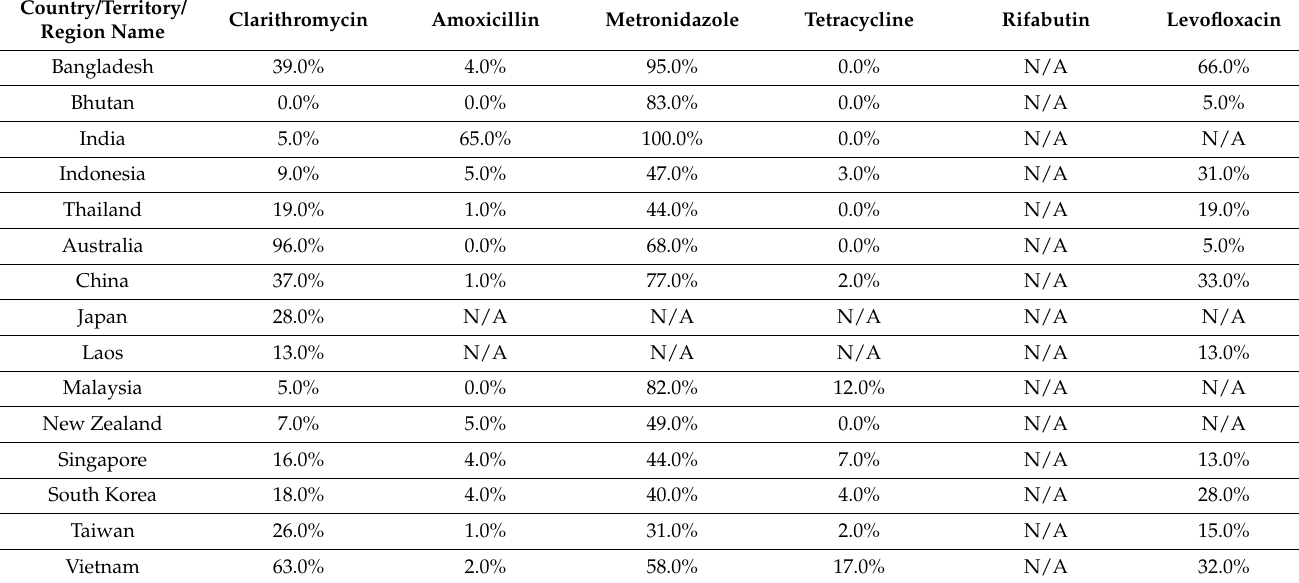
Table 7. Asia and Oceania Regional Rates of